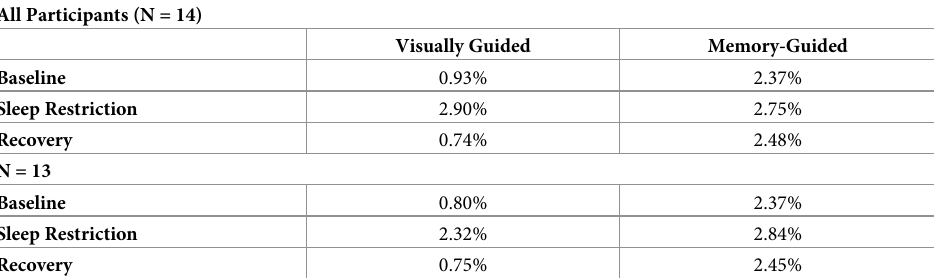
Table 4. Standard deviation of the residuals of force production (% MVC) for experimental conditions, with and without Participant 12. All Participants (N =